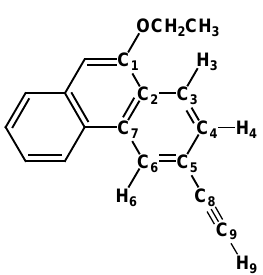
Figure 5. Numbering Scheme for NMR Spectral Assignments